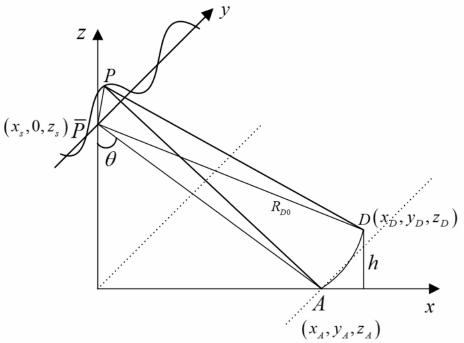
Figure 1. Motion compensation residual error (MCRE) geometry diagram with target elevation